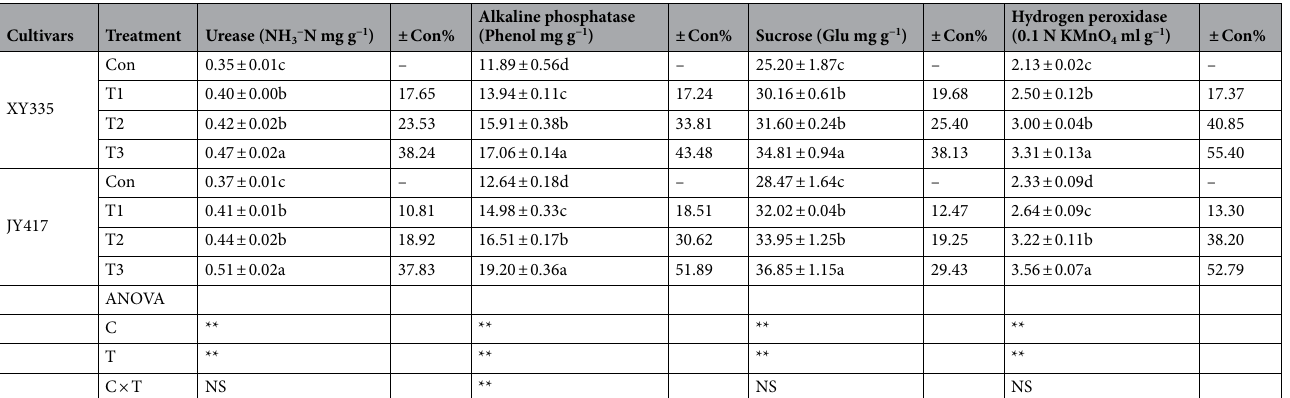
Table 3. Influence of T. asperellum on the enzyme activity of maize seedlings rhizosphere soil (± SD). Con, T1, T2, and T3 indicate 0, 1 × 10 3 , 1 × 10 6 , 1 × 10 9 spores L −1 suspension, respectively. Soil enzyme activity was measured on the 27th day after T. asperellum application. C and T indicated cultivars and treatments, respectively. Different letters within a column represented significant differences at 5% probability level, and the numerical value was the mean value of five repeats. Differences between treatments were calculated for each particular cultivar. NS, not significant. * and **, significant at the 0.05 and 0.01 probability level,